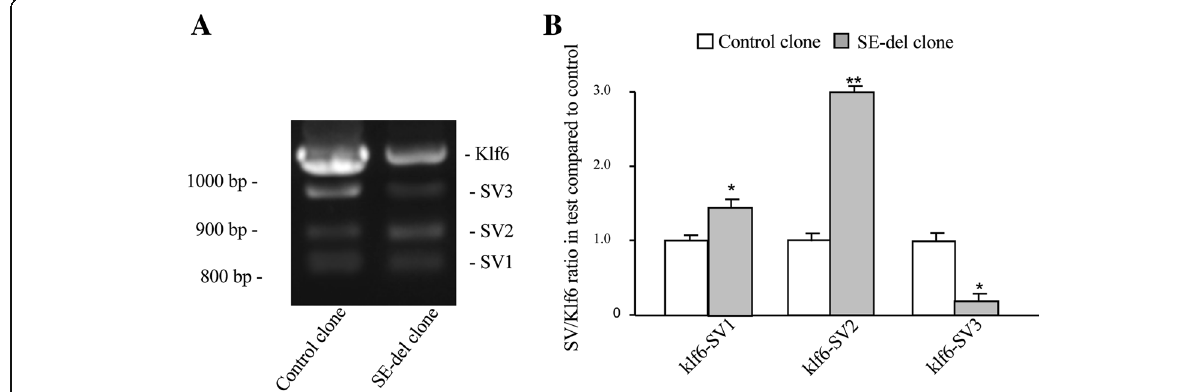
Fig. 2 Expression of Klf6-SV isoforms in the target clones. a RT-PCR of cDNAs with Klf6 variant-specific primers [9]. PCR products were visualized after agarose gel electrophoresis and ethidium bromide staining. b SV/Klf6 mRNA ratio analysis by qRT-PCR. The figure shows Klf6-SV expression relatively to Klf6 expression in the target clones. The results are the mean of three different quantifications, * p < 0.05, ** p <